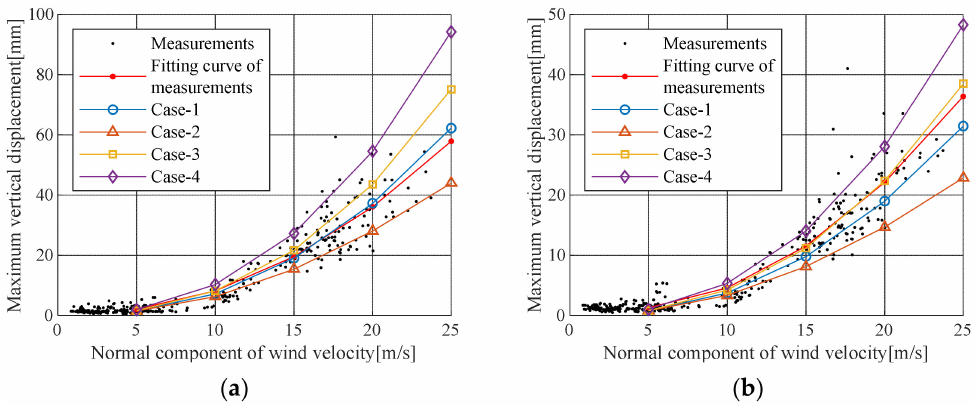
Figure 9. Maximum bu ff eting responses: ( a ) Responses at the center of the mid-span; ( b ) Responses at the quarter point of the